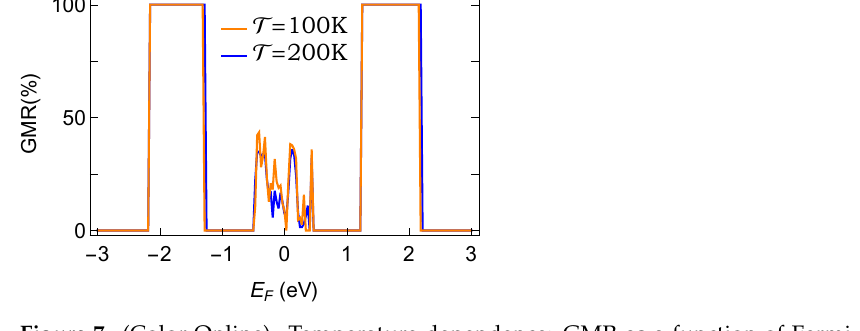
Figure 7. (Color Online). Temperature dependence: GMR as a function of Fermi energy at two different temperatures. Here, we consider A x = 1 and the AAH phase φ ν =